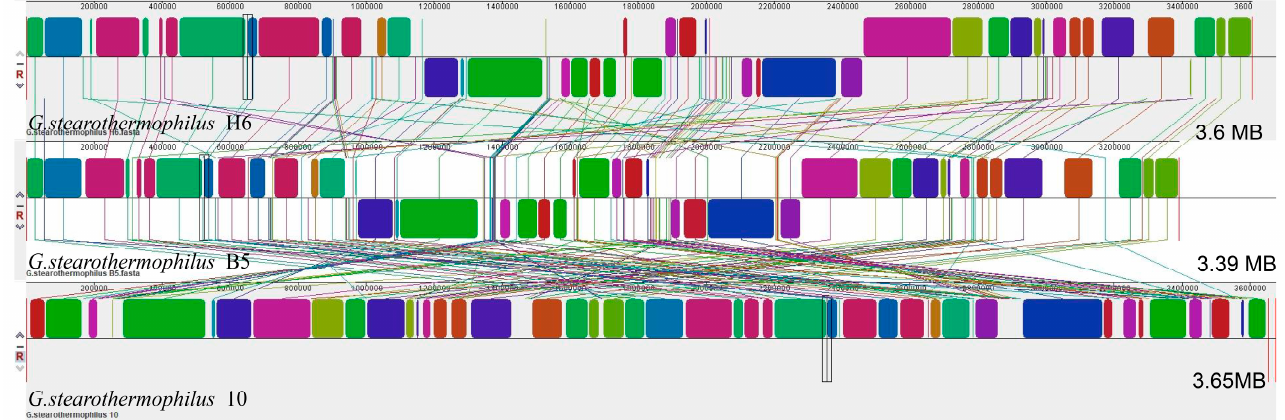
Figure 2. Genomic synteny analysis of G. stearothermophilus H6, G. stearothermophilus B5 and G. stearothermophilus 10. The same color block represents two genomes with high homology.